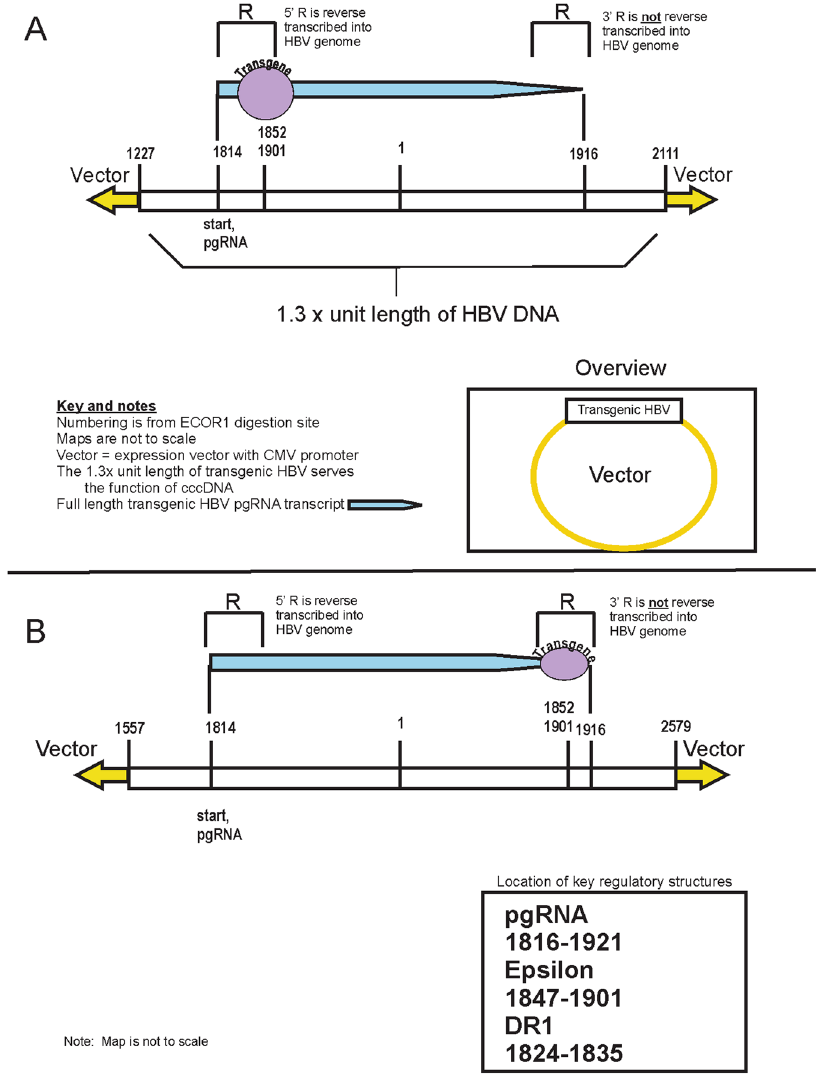
Figure 1. Transgenic HBV maps. Panel (A) Map of the “front” transgenic HBV, where the foreign gene is inserted within the first R region. Sequence numbering is from the traditional EcoR1 digestion site in the hepatitis B genome. Panel (B). Map of the “back” transgenic HBV, where the foreign gene is inserted within the first R